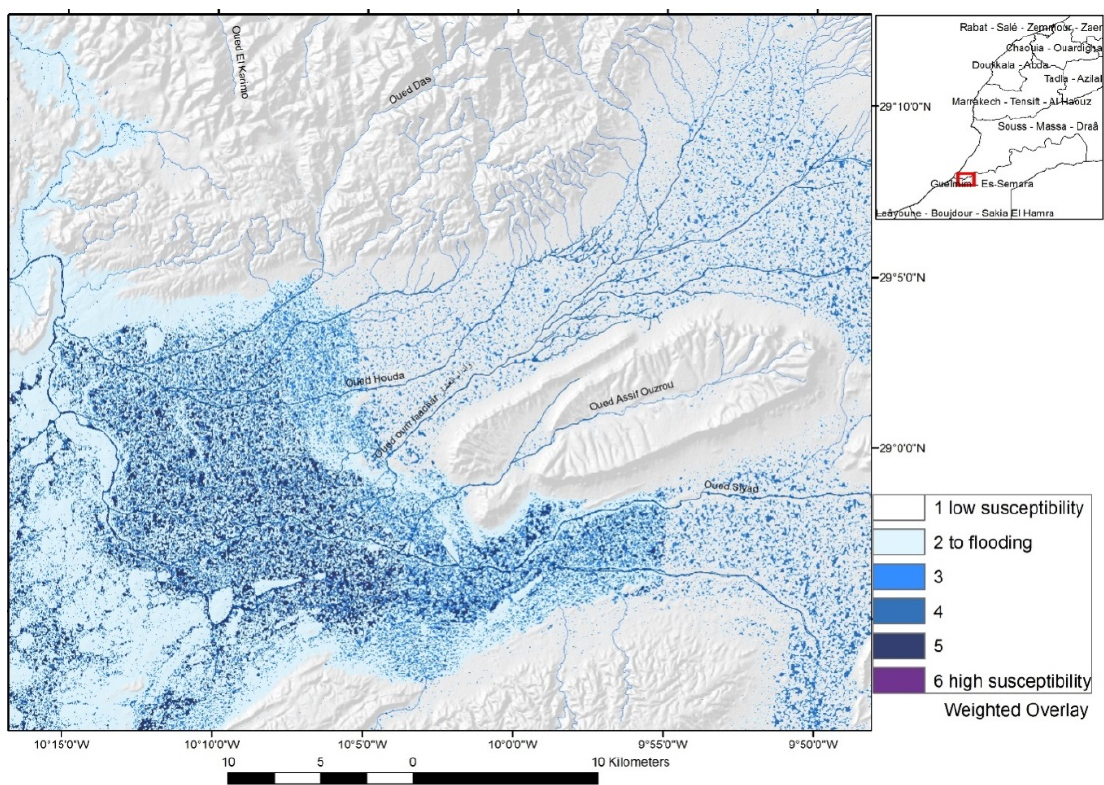
Figure 10. Areas susceptible to flooding due to the aggregation of causal, morphometric